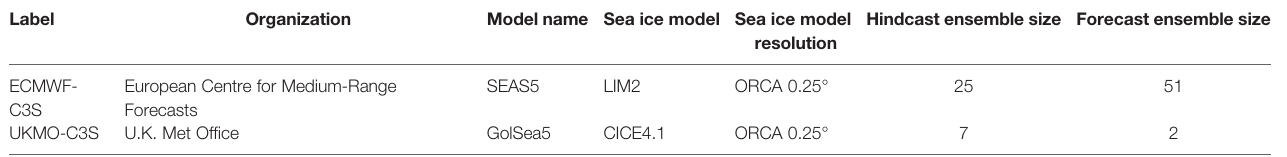
TABLE 1 | Brief information of the two C3S models.